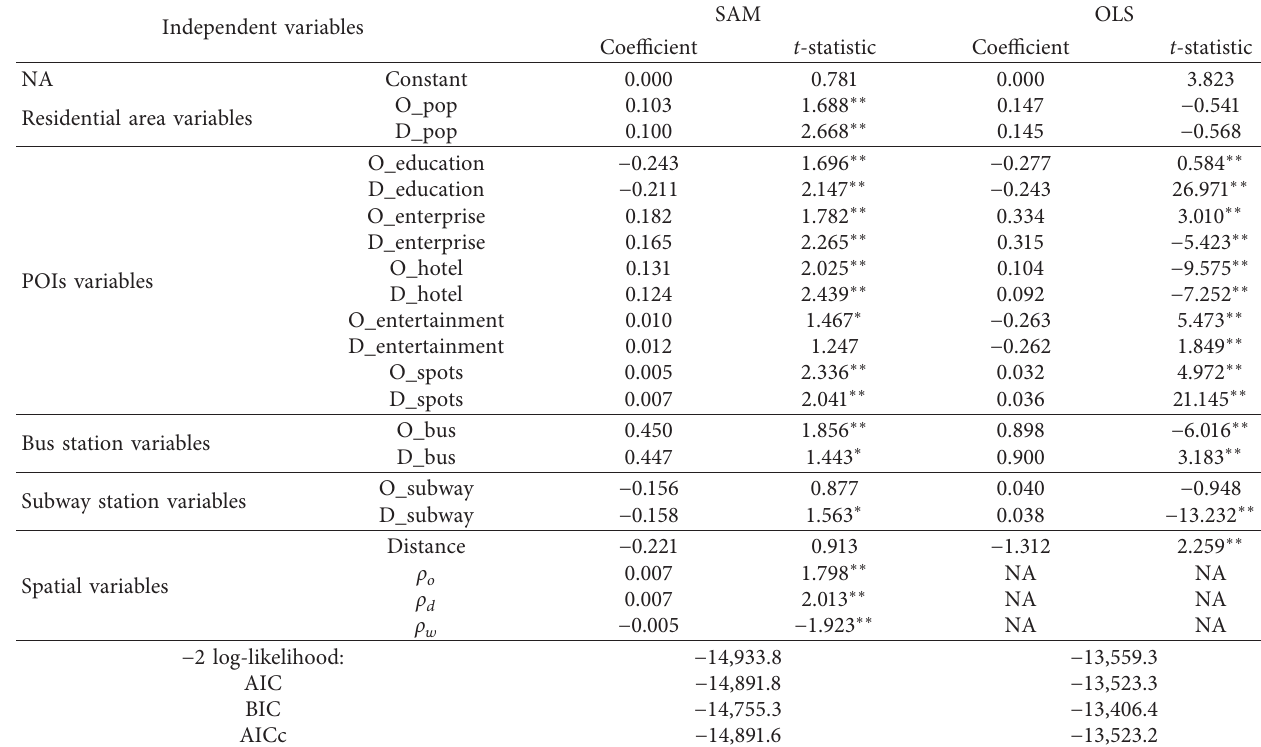
Table 4: Coefficients of SAM and OLS.